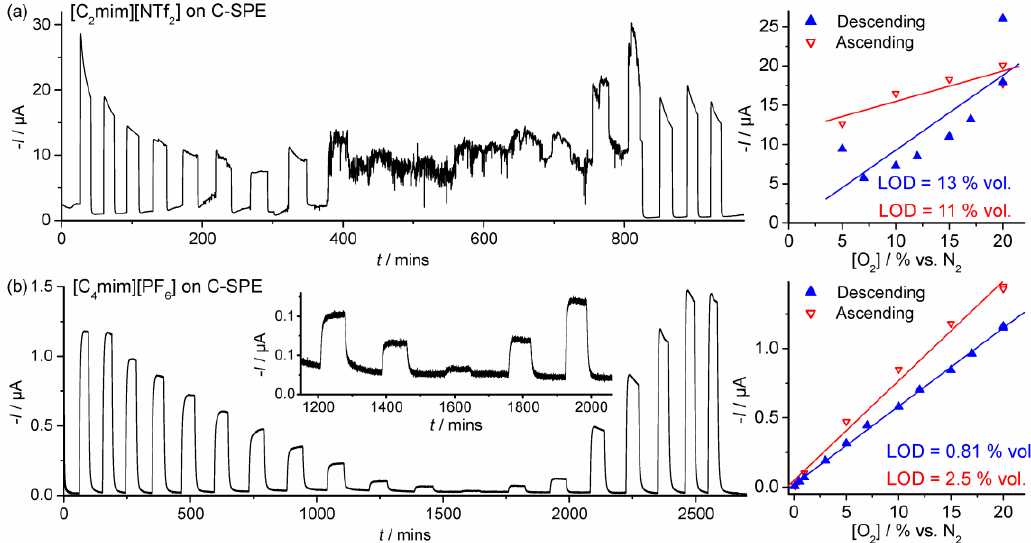
Figure 5. ( Left ) LTCA for different concentrations of oxygen in ( a ) [C 2 mim][NTf 2 ] and ( b ) [C 4 mim][PF 6 ] on a DropSens C-SPE for 20, 20, 17, 15, 12, 10, 7, 5, 3, 1, 0.5, 0.1, 0.5, 1, 5, 10, 15, 20, and 20% vol. O 2 alternating with periods of N 2 purging, conducted at 0.15 to 0.20 V negative to the O 2 reduction peak potentials. The inset shows a plot zoomed into the lowest concentrations (1, 0.5, 0.1, 0.5, and 1% vol. O 2 ). ( Right ) Calibration plots for the initial descending and subsequent ascending change in O 2 concentrations.